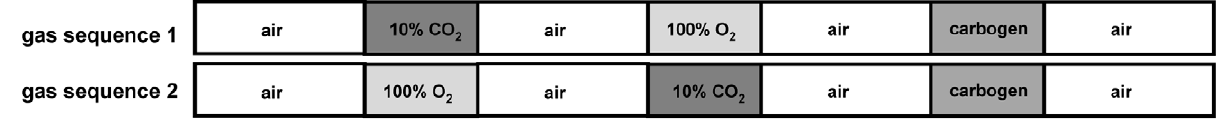
Figure 1. Gas inhalation protocol. Baseline air is delivered in 15 minute blocks. All other gases are delivered in 10 minute blocks.